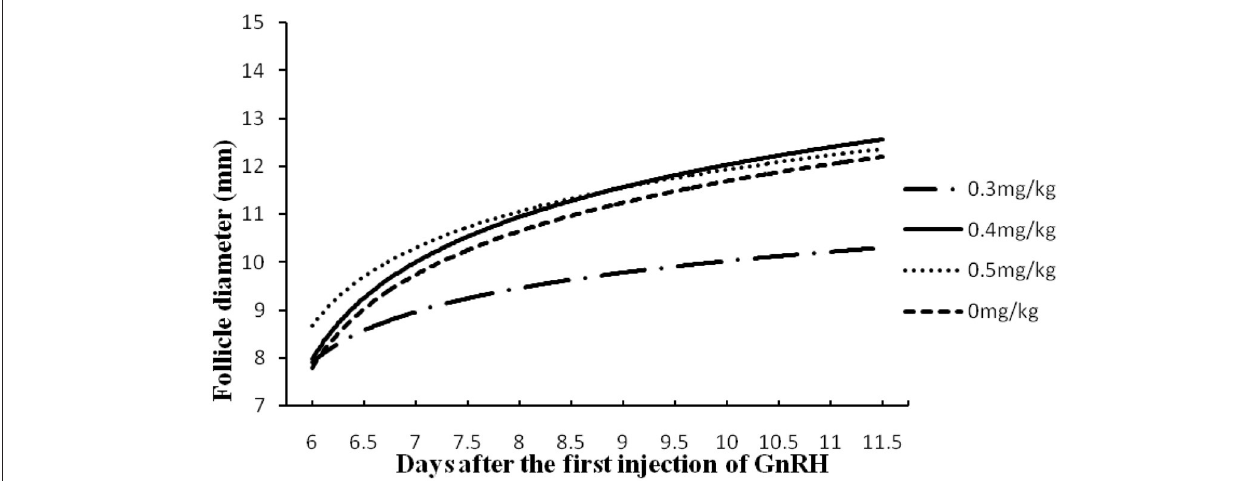
FIGURE 4 | Follicular development in buffaloes synchronized by GPGMH with different doses of mifepristone (0, 0.3, 0.4 and 0.5 mg/kg). Values in both X- and Y-coordinates were transformed in logarithm for comparison of groups.